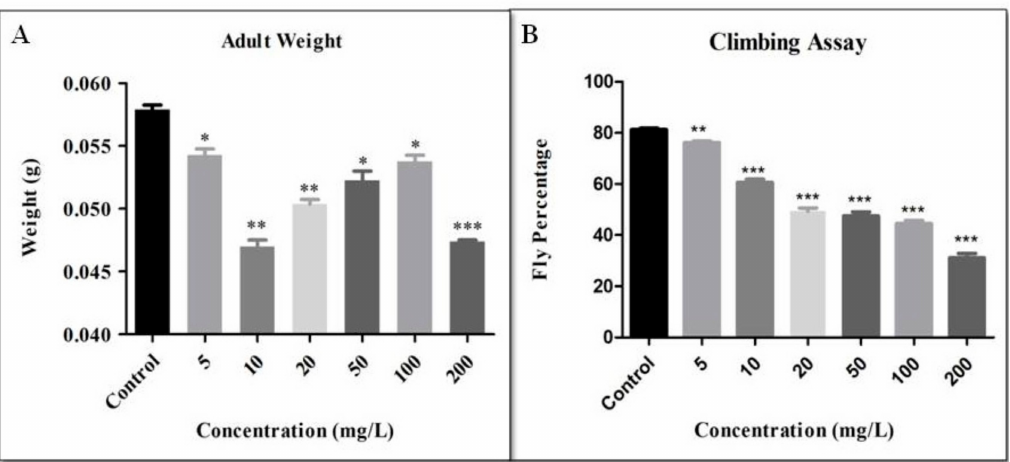
Figure 5. ( A ) Weight of 50 adult flies (25 males and 25 females) was measured and plotted on the graph (weight in grams). ( B ) Climbing assay to check the flies ability to climb up the walls of a measuring cylinder up to a certain distance (80 mL or 16 cm of a 100 mL measuring cylinder) (* for p -value < 0.05, ** for p -value < 0.001, *** for p -value < 0.0001).